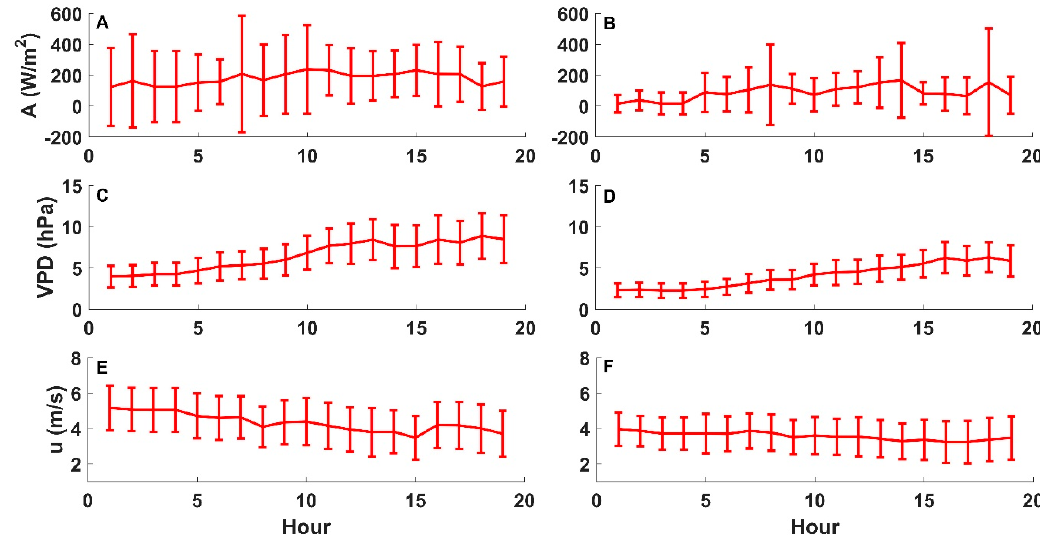
Figure 8. Diurnal variations in A, VPD, and u during the high-water ( A , C , E ) and low-water ( B , D , F ) periods in 2015. The length of the bar in each subfigure represents the value of the standard deviation of the variable. Table 3. Stepwise regression analysis for α during both the high-water and low-water periods at daily and subdaily scales. RMSE represents the root mean squared error of the prediction from the regression equation. r represents the correlation coe ffi cient between the predictions and “ground-truth” α . Statistics for the Timescales Variables Statistics for Coe ffi cients Regression Equation High-water Coe ffi